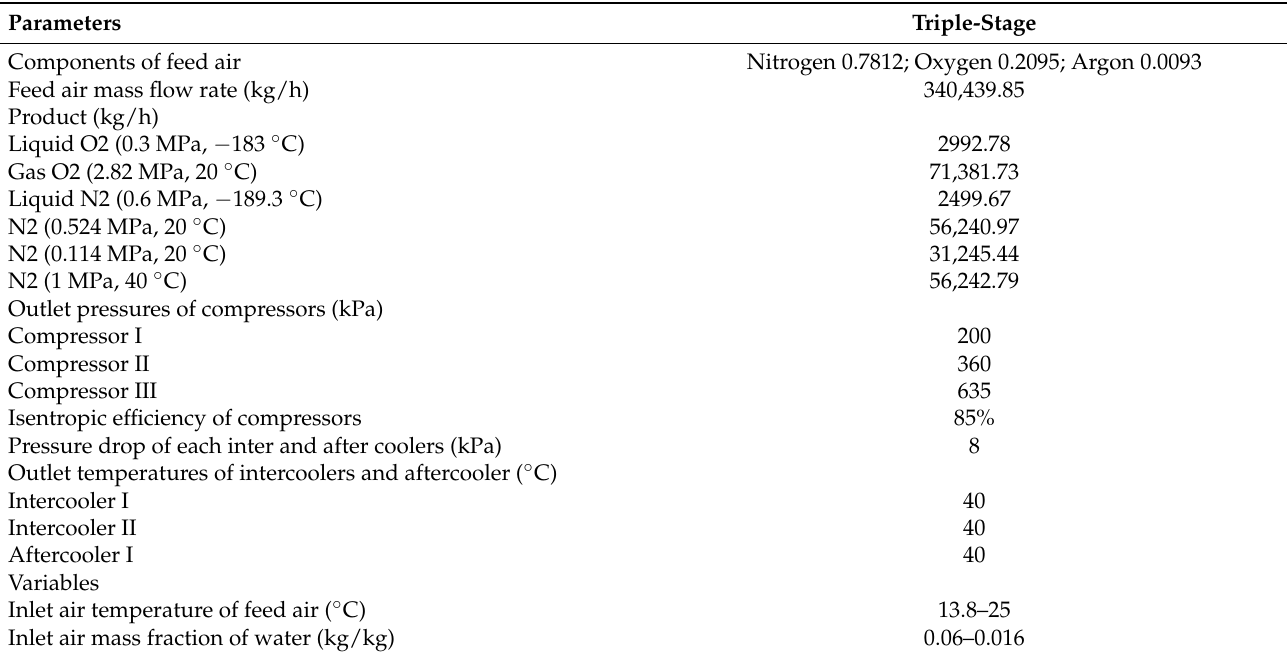
Table 1. Processed parameters in the triple-stage air compression